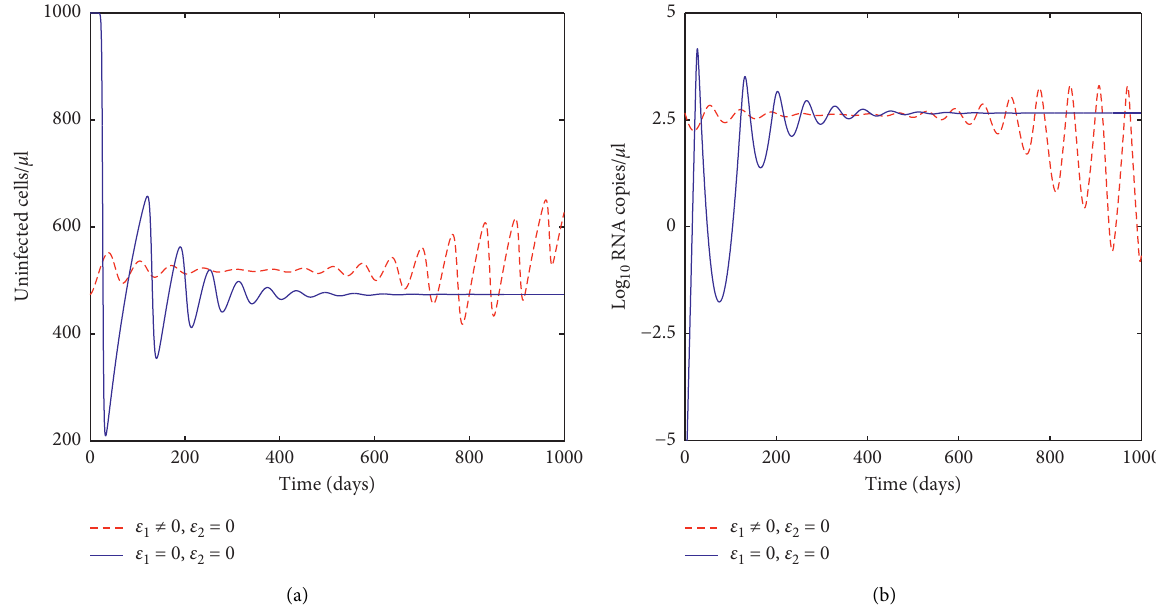
Figure 5: The level of (a) uninfected cells and (b) viral load corresponding to the optimal control strategy with ε without control; dashed lines: with